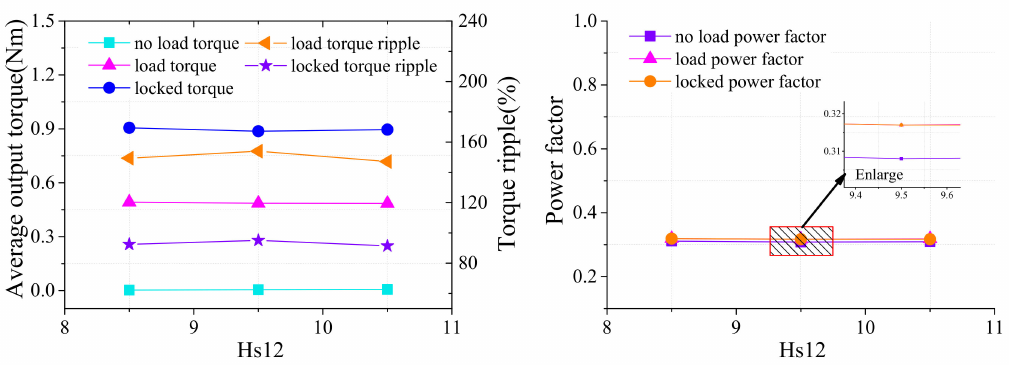
Figure 9. Influence of slot height on average output torque and power factor at no load, load, and